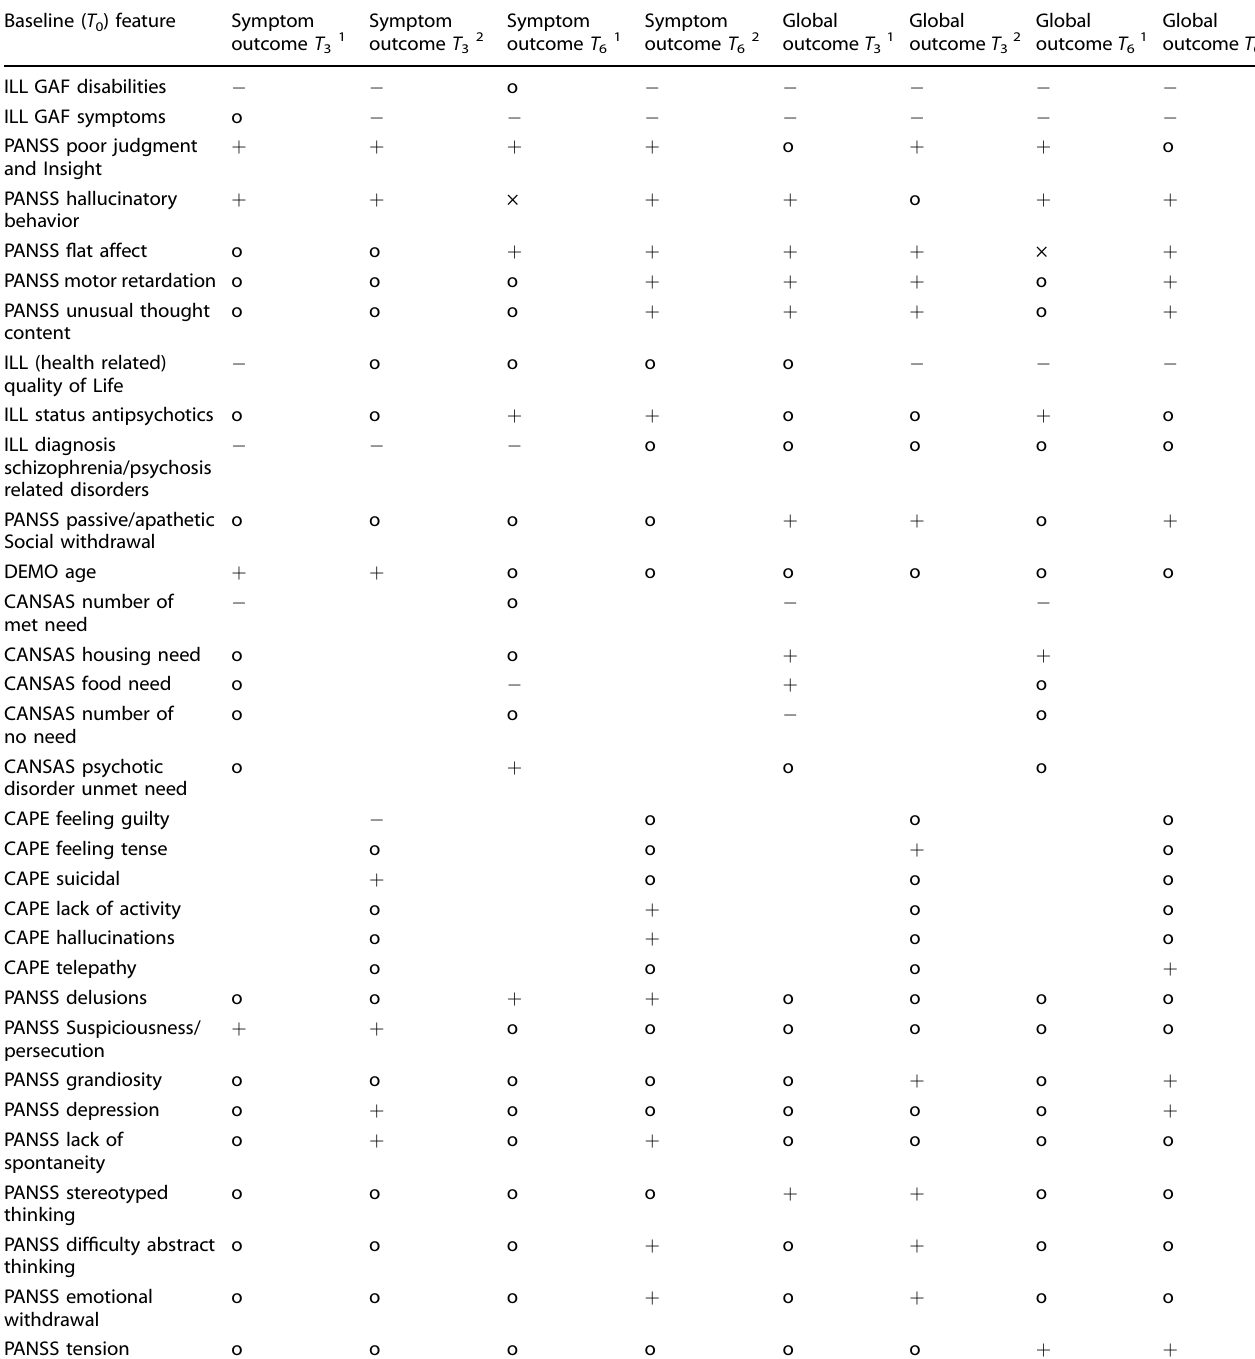
Table 3. Important baseline features by model. Baseline ( T 0 )